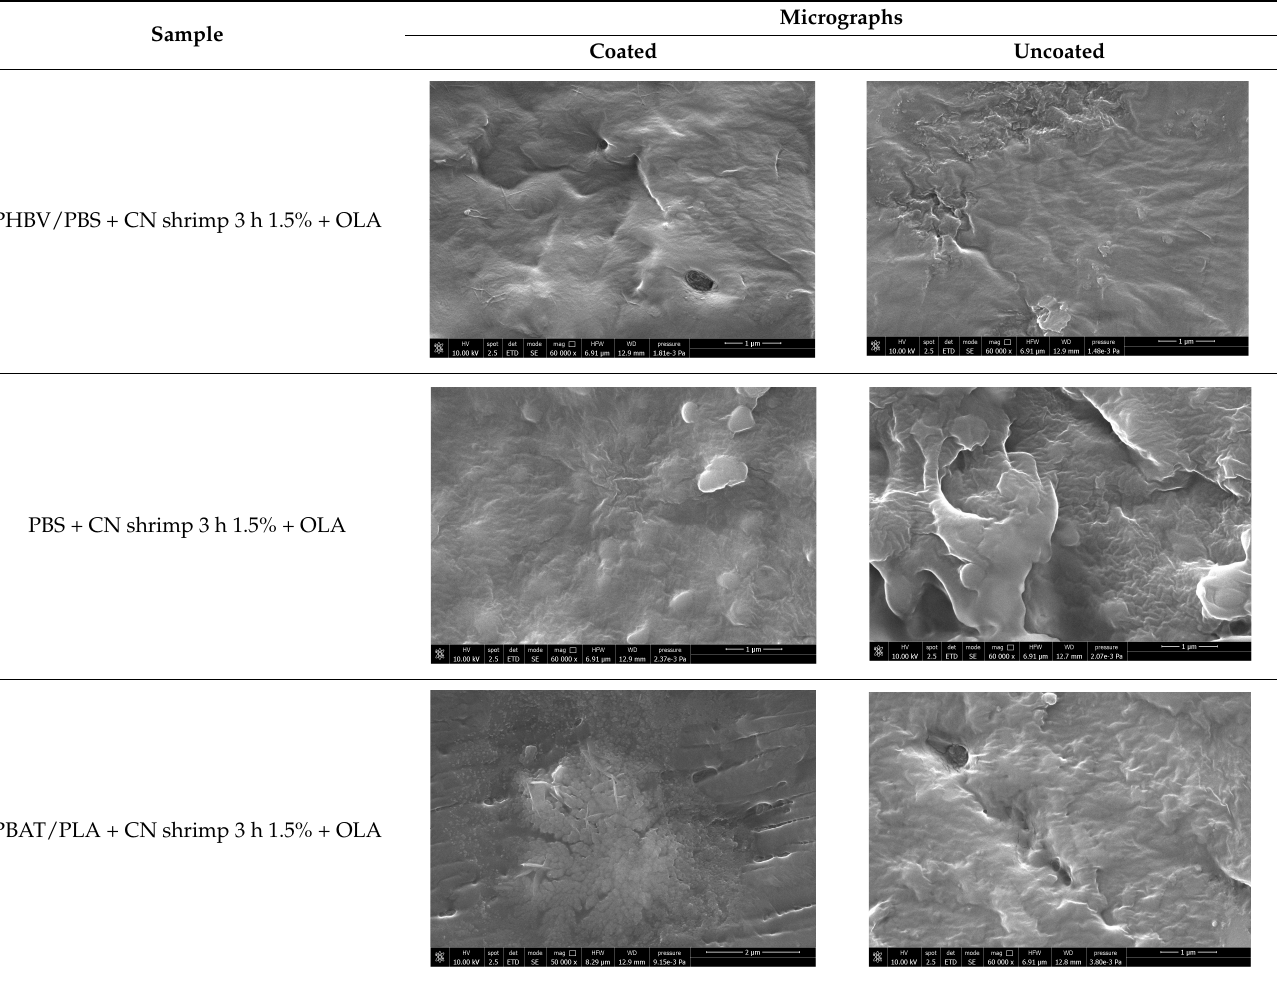
Table 8. Micrographs of coated and uncoated substrates. Table 8. micrographs of coated and uncoated substrates. Table 8. micrographs of coated and uncoated substrates. Table 8. micrographs of coated and uncoated substrates. Table 8. micrographs of coated and uncoated substrates. Table 8. micrographs of coated and uncoated substrates. Table 8. micrographs of coated and uncoated